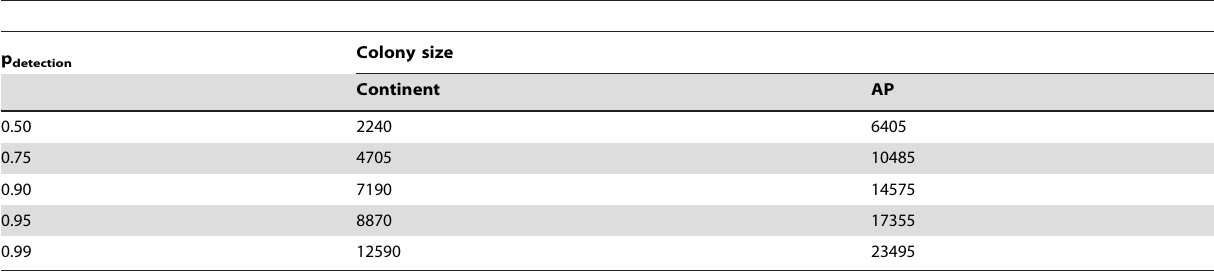
Table 1. Probability of detection using Landsat-7 retrieval algorithm.